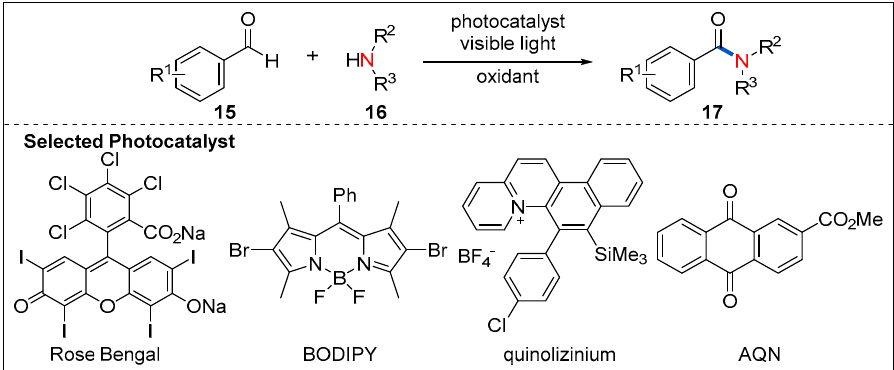
Figure 8. Selected organic photocatalysts for oxidative amidation of aldehydes.